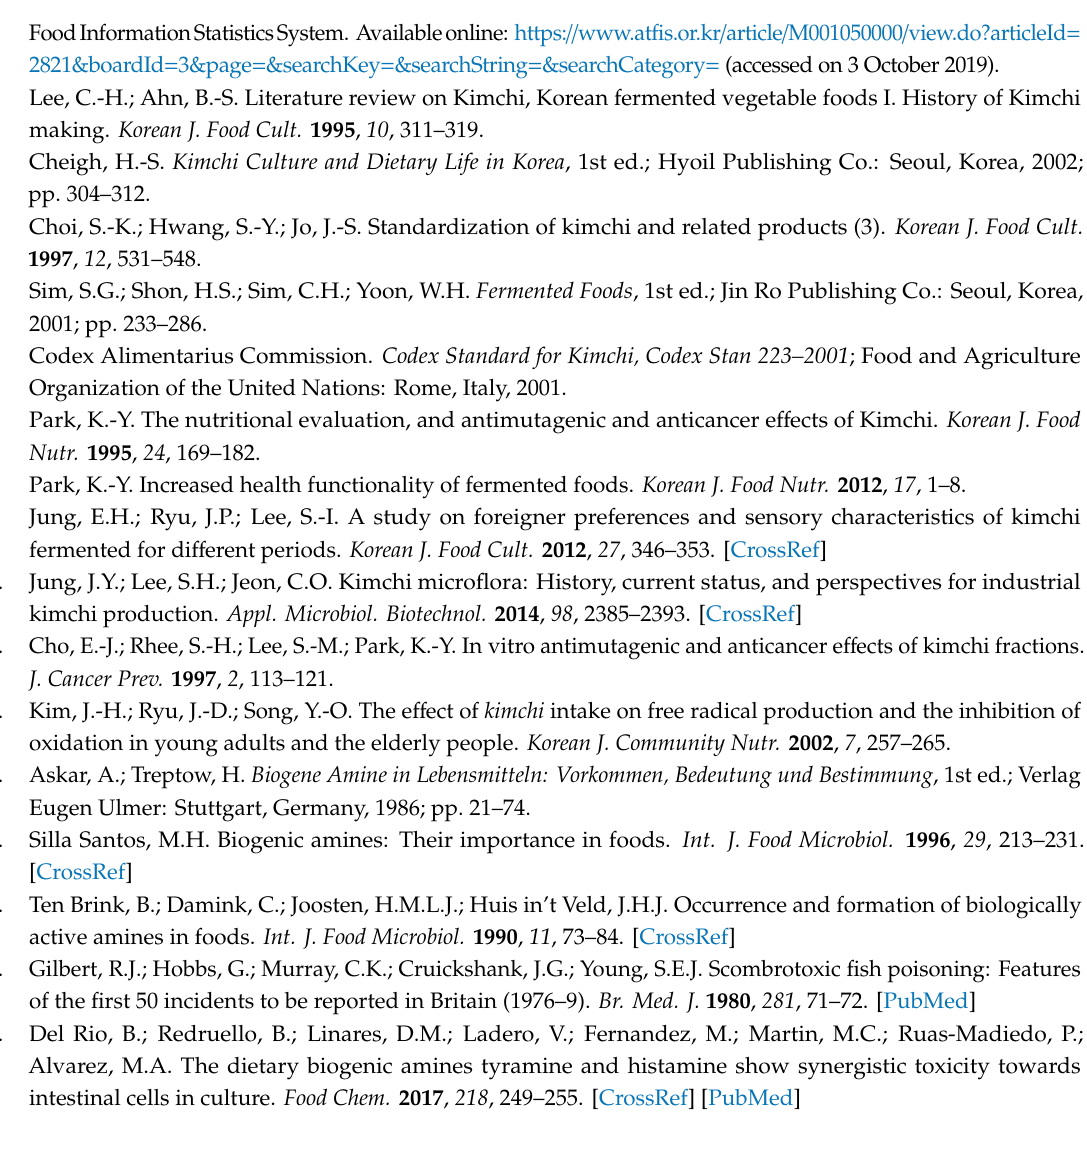
Table S1: Biogenic amine content of fermented vegetable and seafood products from various